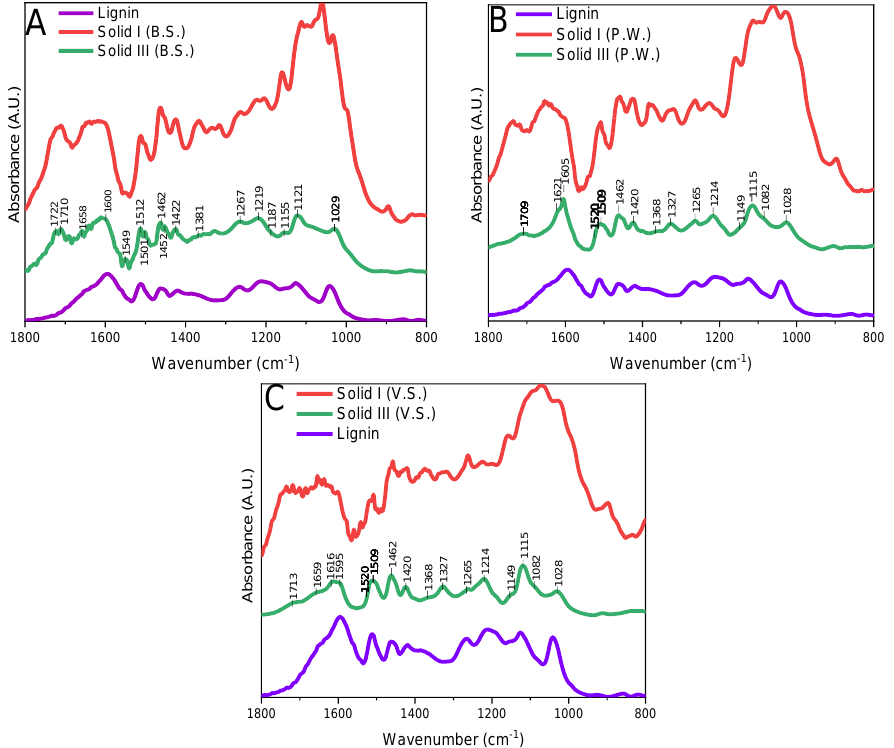
Figure 4. FTIR spectra of Solid I, Solid II, Solid III, and lignin (( A ) B.S.: barley straw; ( B ) P.W.: pruning waste; ( C ) V.S.: vine shoot).